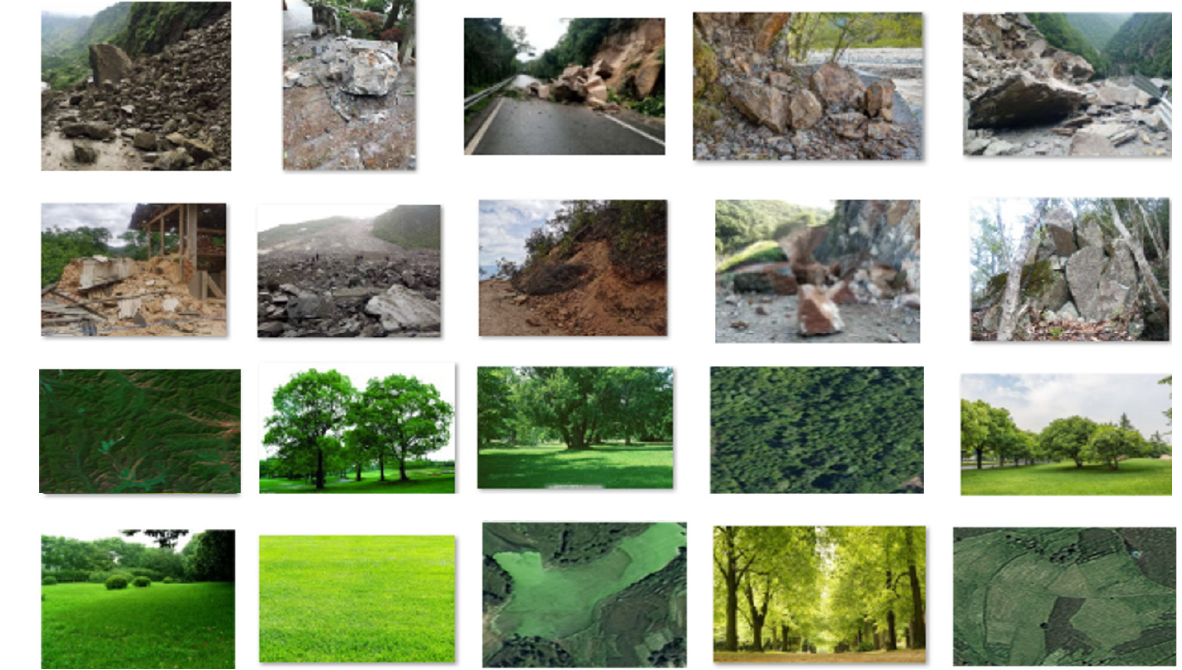
Figure 3. The samples of the source domain datasets.